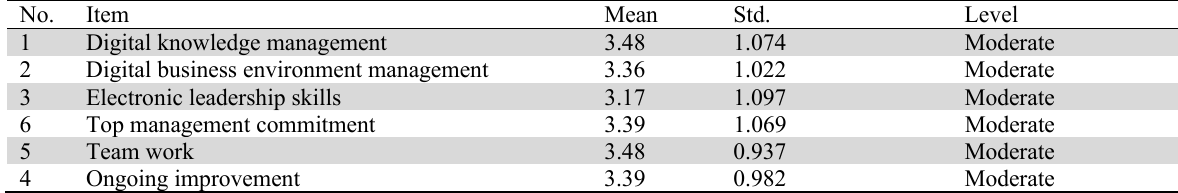
Means and standard deviations of the respondents’ attitudes in terms of each area